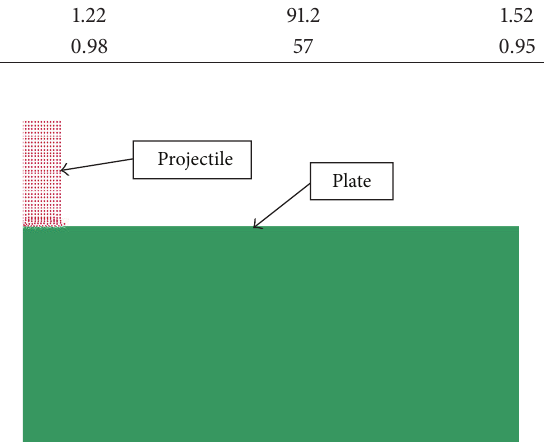
Figure 8: A typical SPH model (zoomed in) with 0.05 mm particle spacing.